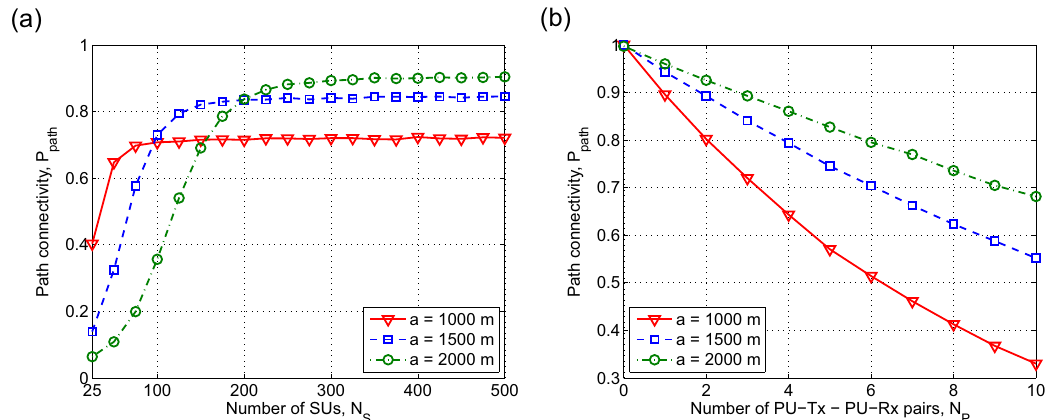
Figure 10. Path connectivity between two arbitrary nodes versus ( a ) the number of SUs, N S , and ( b ) the number of PU-Tx-PU-Rx pairs, N P , with different network sizes, a . λ P = 0.3, R T = r T = 250 m, R I = r I = 280 m. N P = 3 for (a) and N S = 300 for